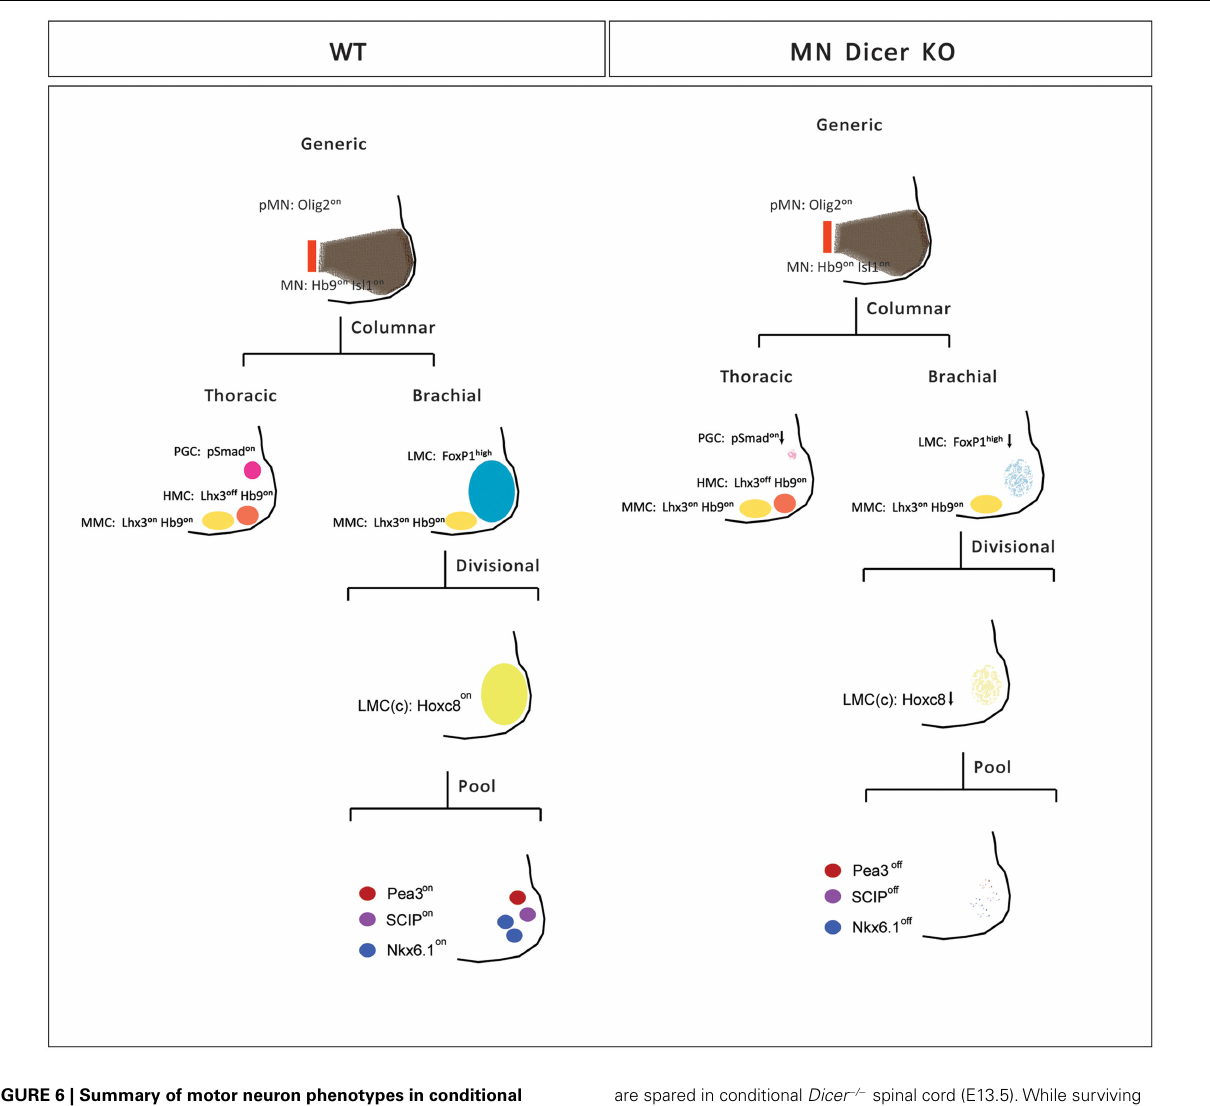
are spared in conditional Dicer − / − spinal cord (E13.5).While surviving caudal brachial LMC motor neurons in Dicer mutants express correctly Hoxc6 and Hoxc8 factors, expression of motor pool markers is significantly eroded resulting in near absence of motor neurons with defined motor pool subtype identity in E14.5 mutant caudal brachial spinal